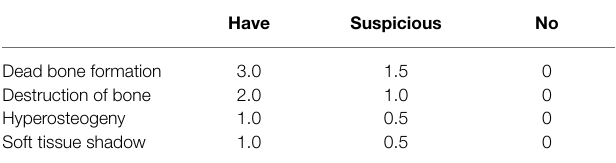
TABLE 2 | Smeltzer’s histological